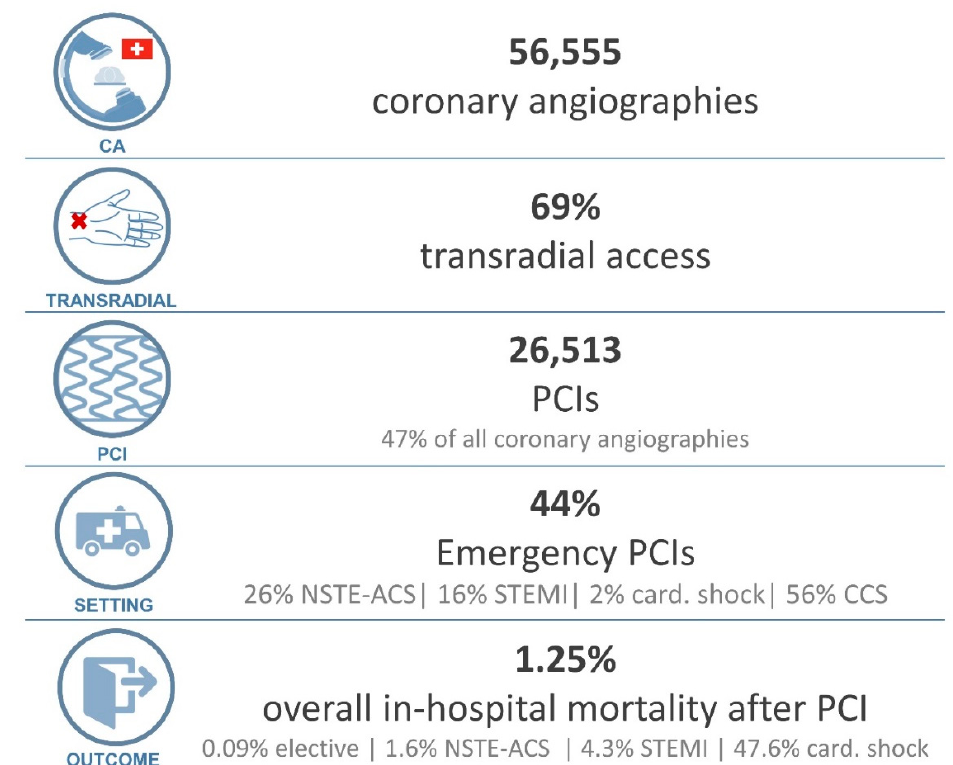
Figure 4. Coronary interventions in 2021: From top to bottom: box 1: Coronary angiographies; box 2: radial access rate; box 3: percutaneous coronary interventions; box 4: Indication for PCI; box 5: outcomes after PCI. (CA: coronary angiographies, card: cardiogenic, CCS: chronic coronary syndrome, PCI: percutaneous coronary intervention, NSTE-ACS: non ST-elevation acute coronary syndrome, STEMI: ST-elevation myocardial infarction).